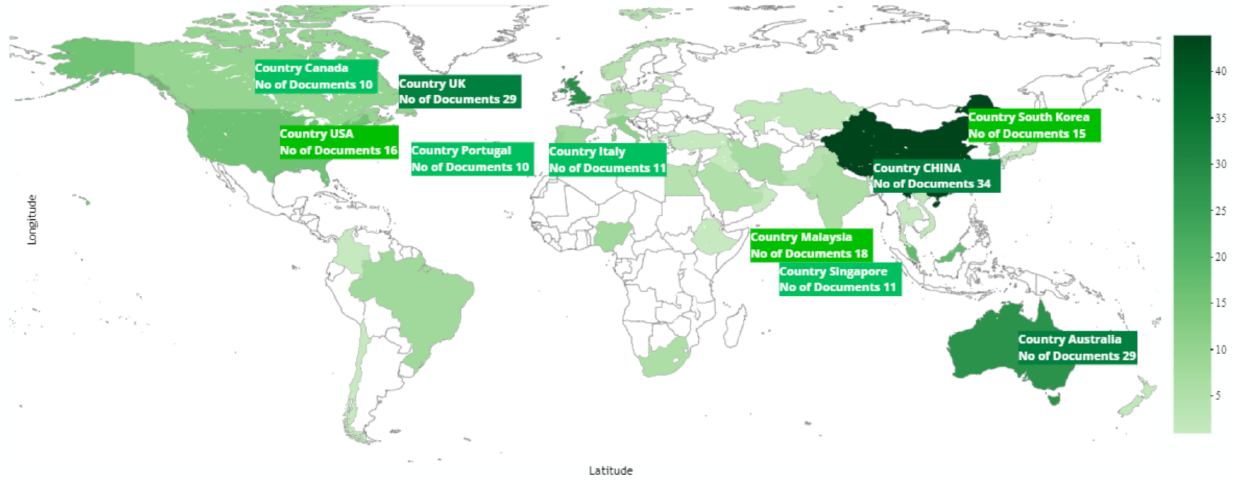
Figure 3. Geographic dispersion of publications on C4.0 and SD.